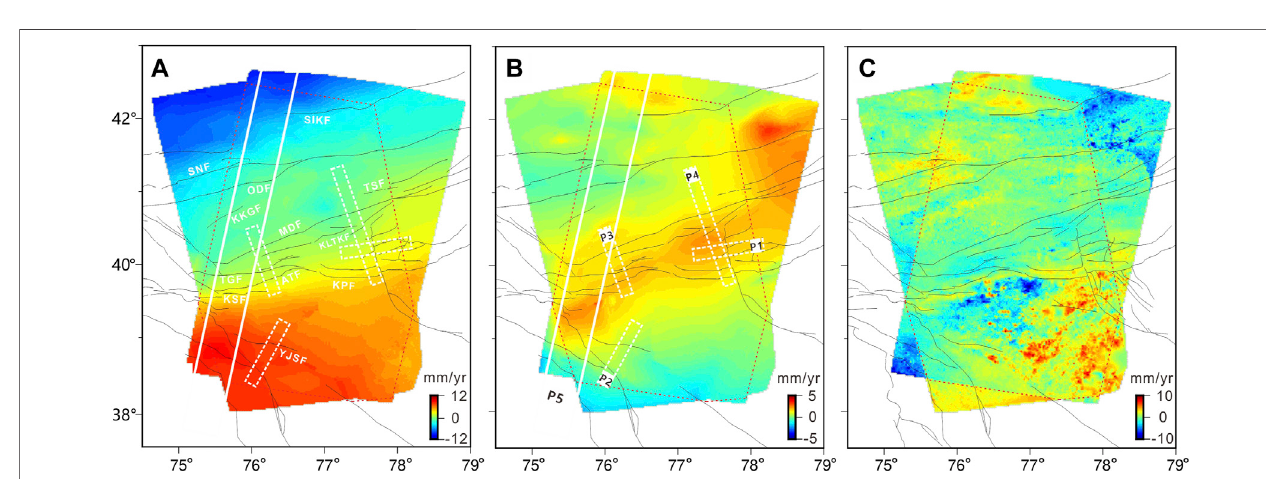
FIGURE 3 | horizontal deformation map. (A) deformation for the north-south component and positive toward north. (B) deformation for the east-west component and positive toward east. (C) deformation for the vertical component and positive toward up.